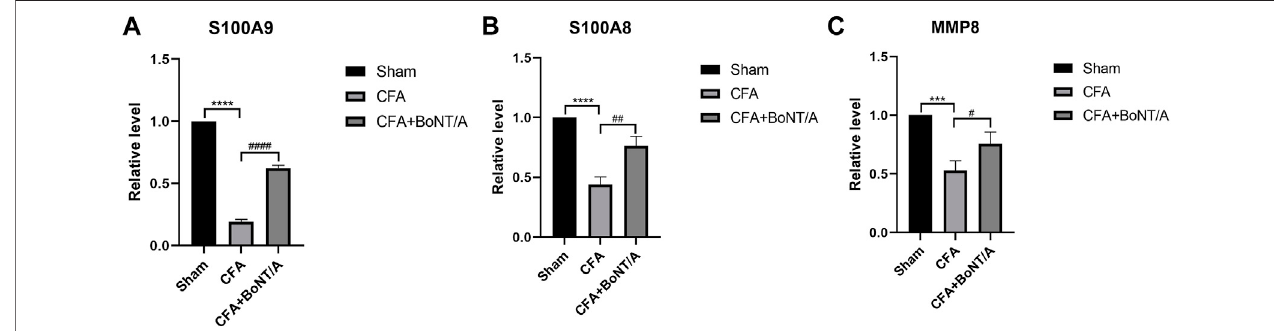
FIGURE6| qRT-PCRresultsshowthattheexpressionlevelsof (A) S100A9, (B) S100A8,and (C) MMP8wereobviouslylowerafterinjectionofCFA.AfterBoNT/A application, S100A9, S100A8, and MMP8 were obviously upregulated (**** p < 0.0001, *** p < 0.001, CFA group vs. Sham group; #### p < 0.0001, ## p < 0.01, # p < 0.05, CFA+BoNT/A group vs. CFA